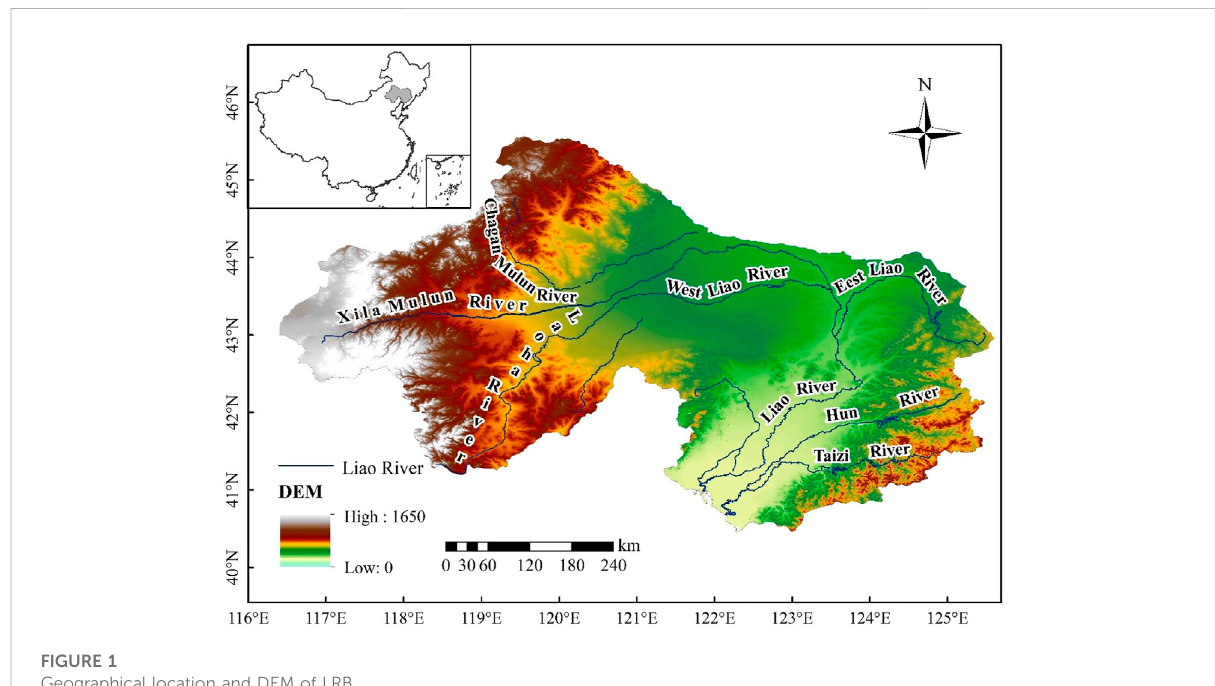
FIGURE 1 Geographical location and DEM of LRB.